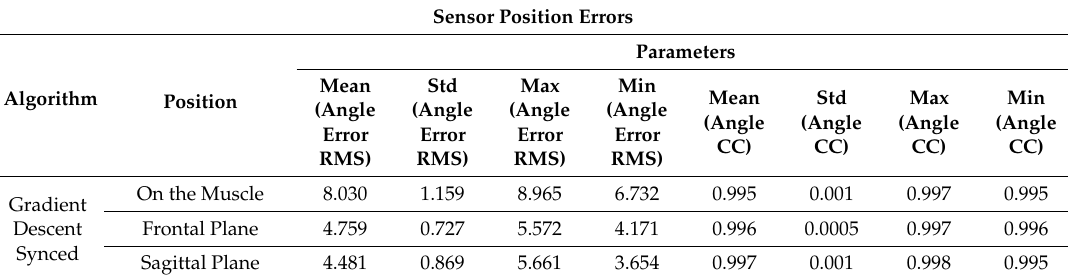
Table 3. RMS (in ◦ ) and Correlation Coefficient (CC) between knee angles estimated using different sensor positions Vs universal goniometer.